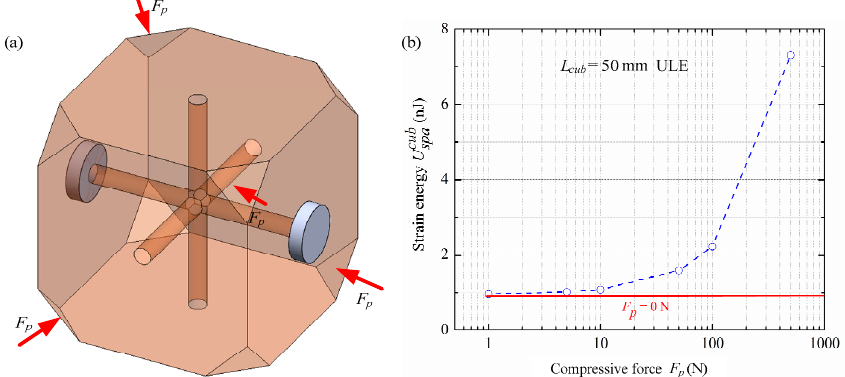
Figure 5. Compressive force model of a cubic optical cavity and strain energy as a function of the compressive force. F p is the compressive force. The red arrows indicate the directions of F p . Blue dashed line with circles represents the simulation results of strain energy of cubic optical cavities. When F p is 0 N, the strain energy U 0 is indicated by a red solid line. Note that L cub and material of the cubic cavity are 50 mm and ULE, respectively. ( a ) Compressive force model of a cubic optical cavity. ( b ) Strain energy as a function of F p .